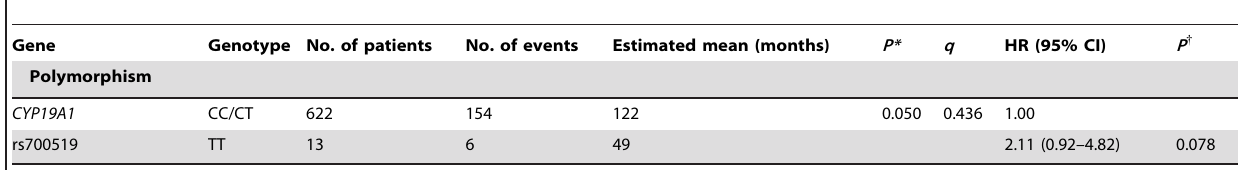
Gene Genotype No. of patients No. of events Estimated mean